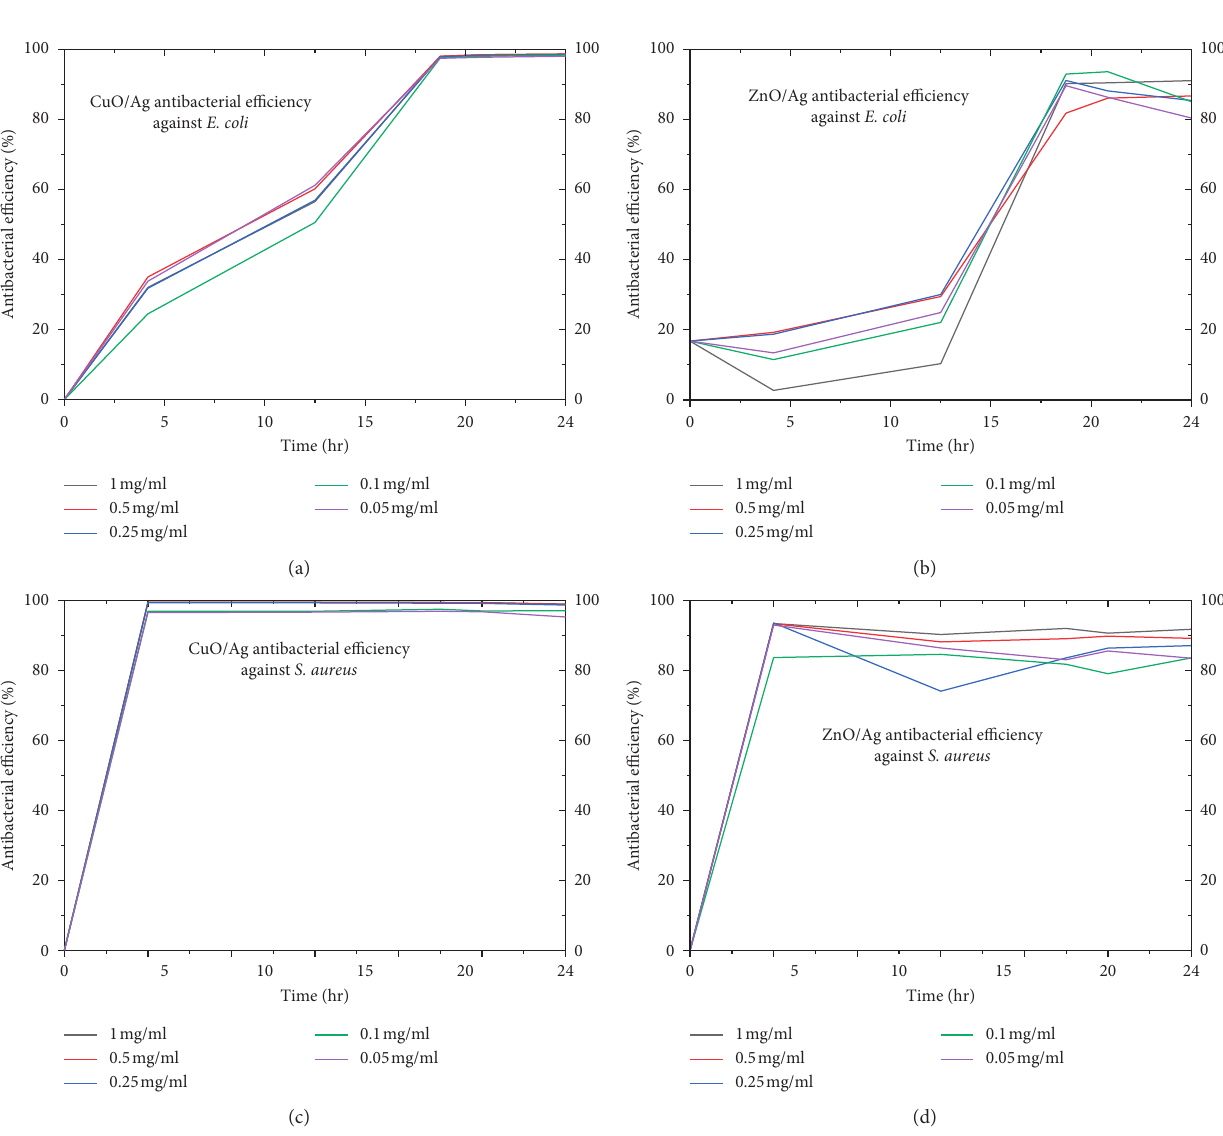
Figure 20: Kinetic growth study on E . coli and S . aureus that are alive after antibacterial activity by (a) CuO/Ag against E . coli , (b) ZnO/Ag against E . coli , (c) CuO/Ag against S . aureus , and (d) ZnO/Ag against S . aureus . Table 3: The results of microdilution test presenting the relative percentages (%) of bacteria cell death by respective nanoparticles after 24 hours of antibacterial kinetic study. “EC” represents Escherichia coli , while “SA” represents Staphylococcus aureus . Conc. of NPs